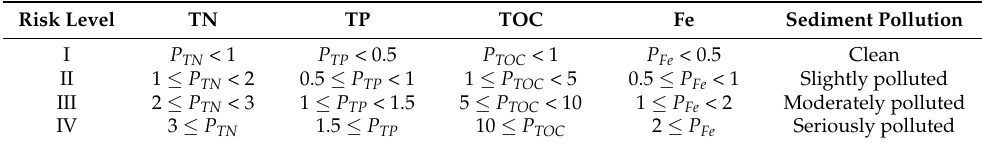
Table 2. Single pollution index SPI i classification.